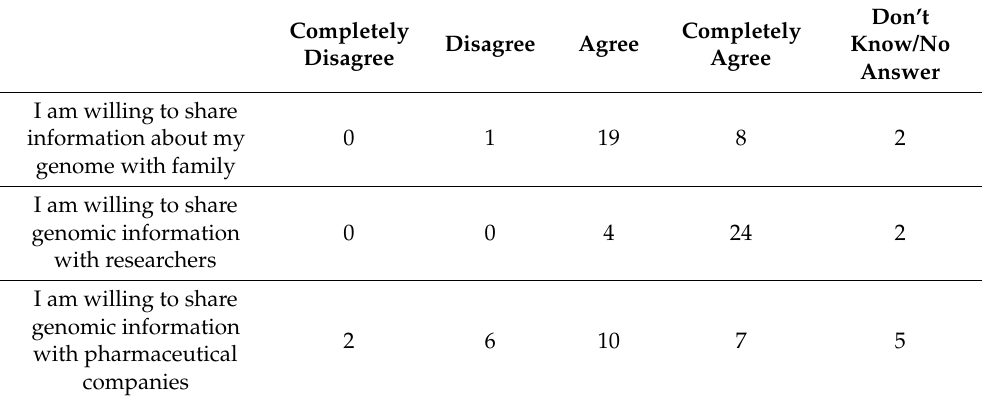
Table 8. Respondents’ perceptions about sharing genomic results with different parties prior to receiving results (pre, n = 30).